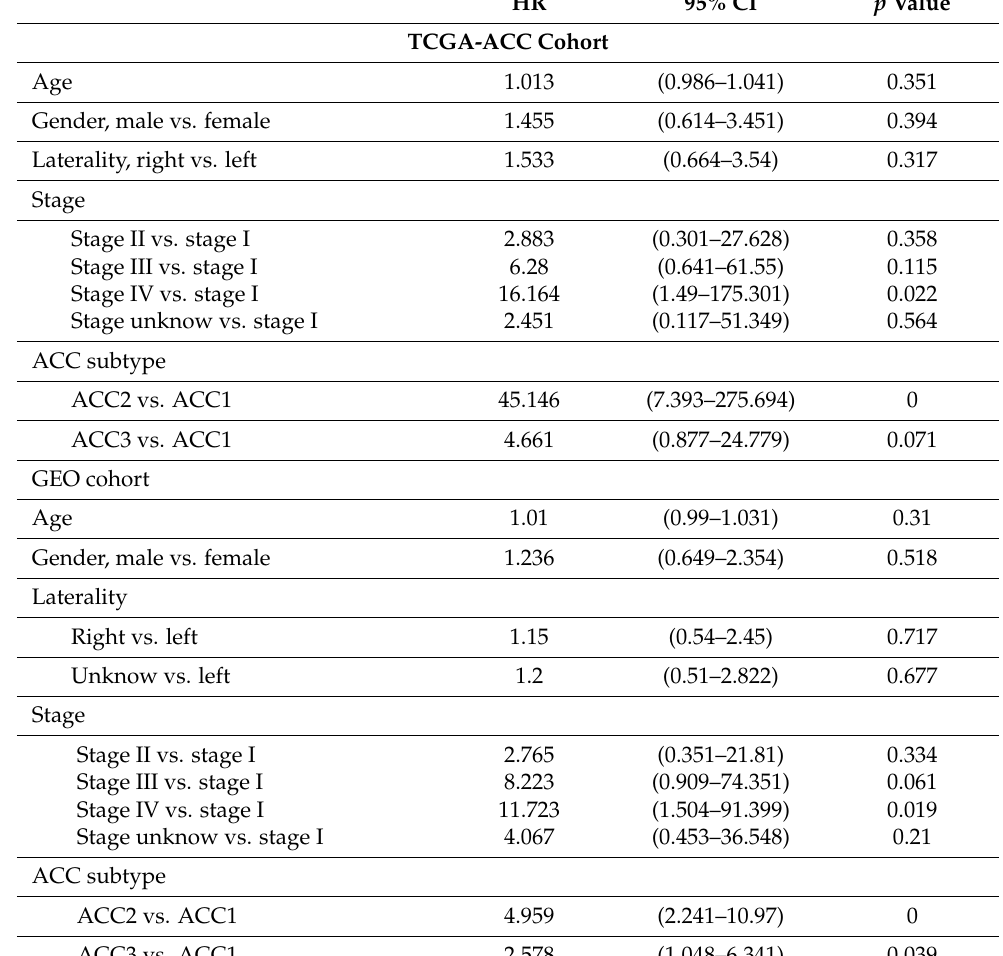
Table 1. Prognostic value of ACC subtype after adjusting for clinicopathological